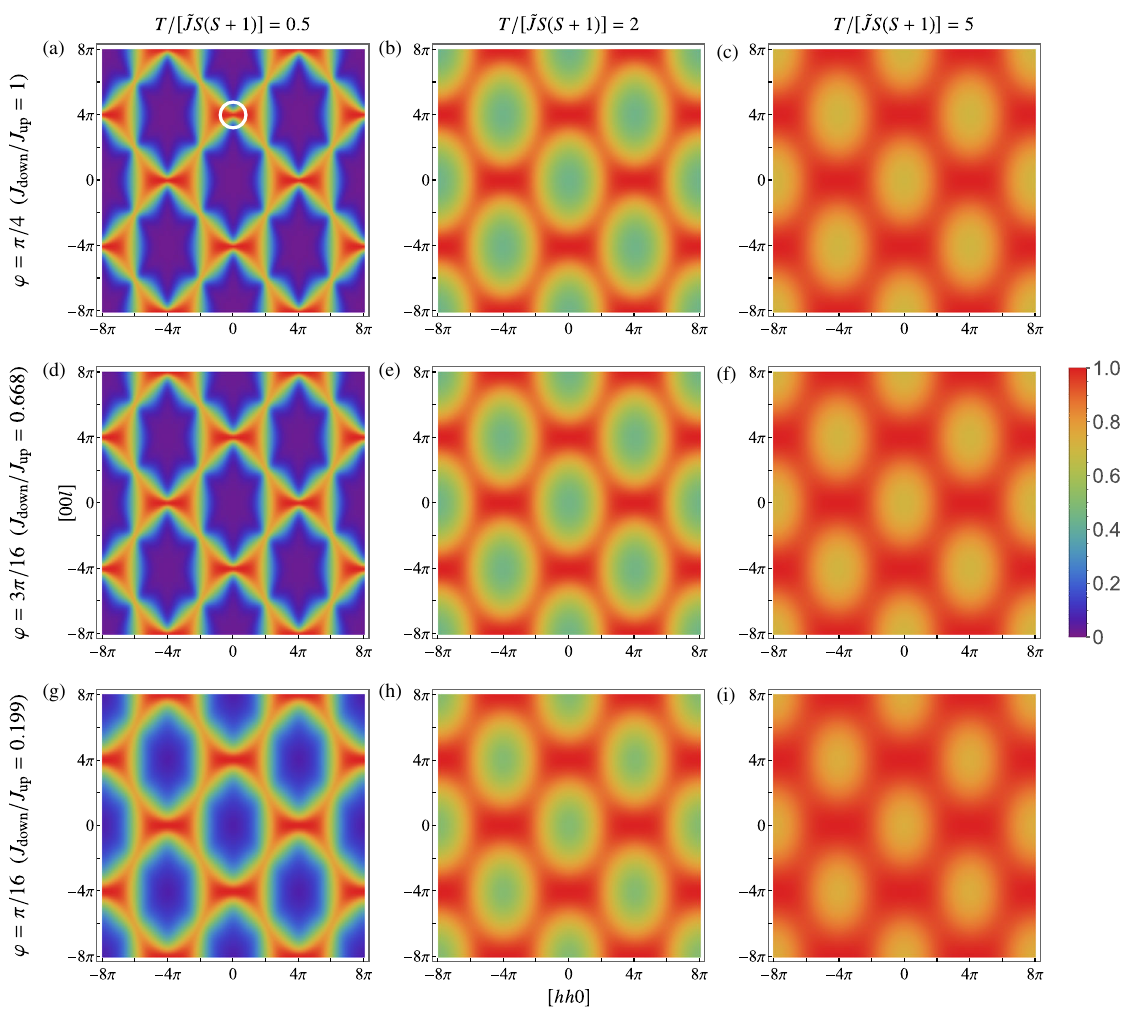
FIG. 3. For the classical ( S → ∞ ) nearest-neighbor Heisenberg antiferromagnet, the spin susceptibility profile (in units of 1 = ½ ˜ JS ð S þ 1 Þ(cid:2) ) in the ½ hhl (cid:2) plane obtained using PFFRG and evaluated for (a) – (c) the isotropic model, (d) – (f) the breathing model for φ ¼ 3 π = 16 , and (g) – (i) the breathing model for φ ¼ π = 16 at three different temperatures: T= ½ T= ½ ˜ JS ð S þ 1 Þ(cid:2) ¼ 2 [(b),(e),(h)], and T= ½ ˜ JS ð S þ 1 Þ(cid:2) ¼ 5 [(c),(f),(i)]. In (a), we encircle the pinch point at k ¼ ð 0 ; 0 ; 4 π Þ . Each plot has its own color scale, where the red corresponds to the maximum of each plot and blue is fixed to